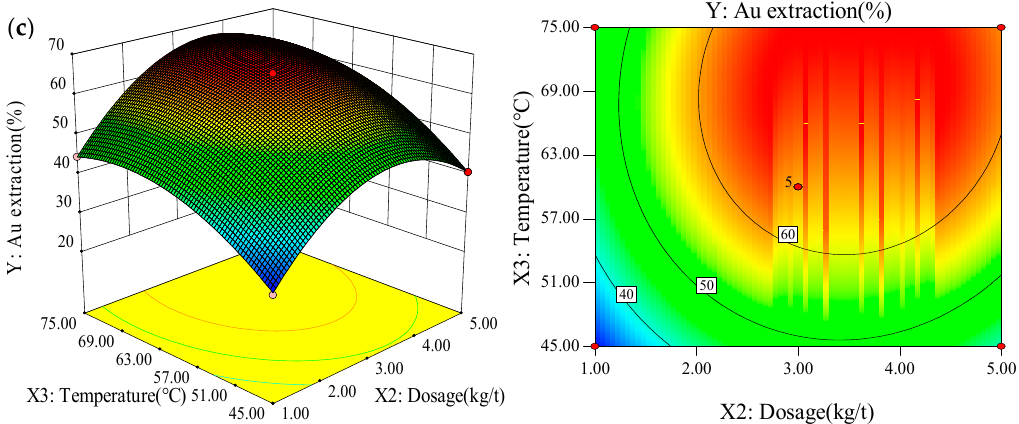
Figure 9. Response surface plots, corresponding contour plots, and interactions between pH (X 1 ), dosage (X 2 ), and temperature (X 3 ) for Au extraction under ultraviolet radiation of 10 mW · cm − 2 high pressure mercury lamp. ( a ) pH vs. dosage ( b ) pH vs. temperature( c ) dosage vs. temperature.